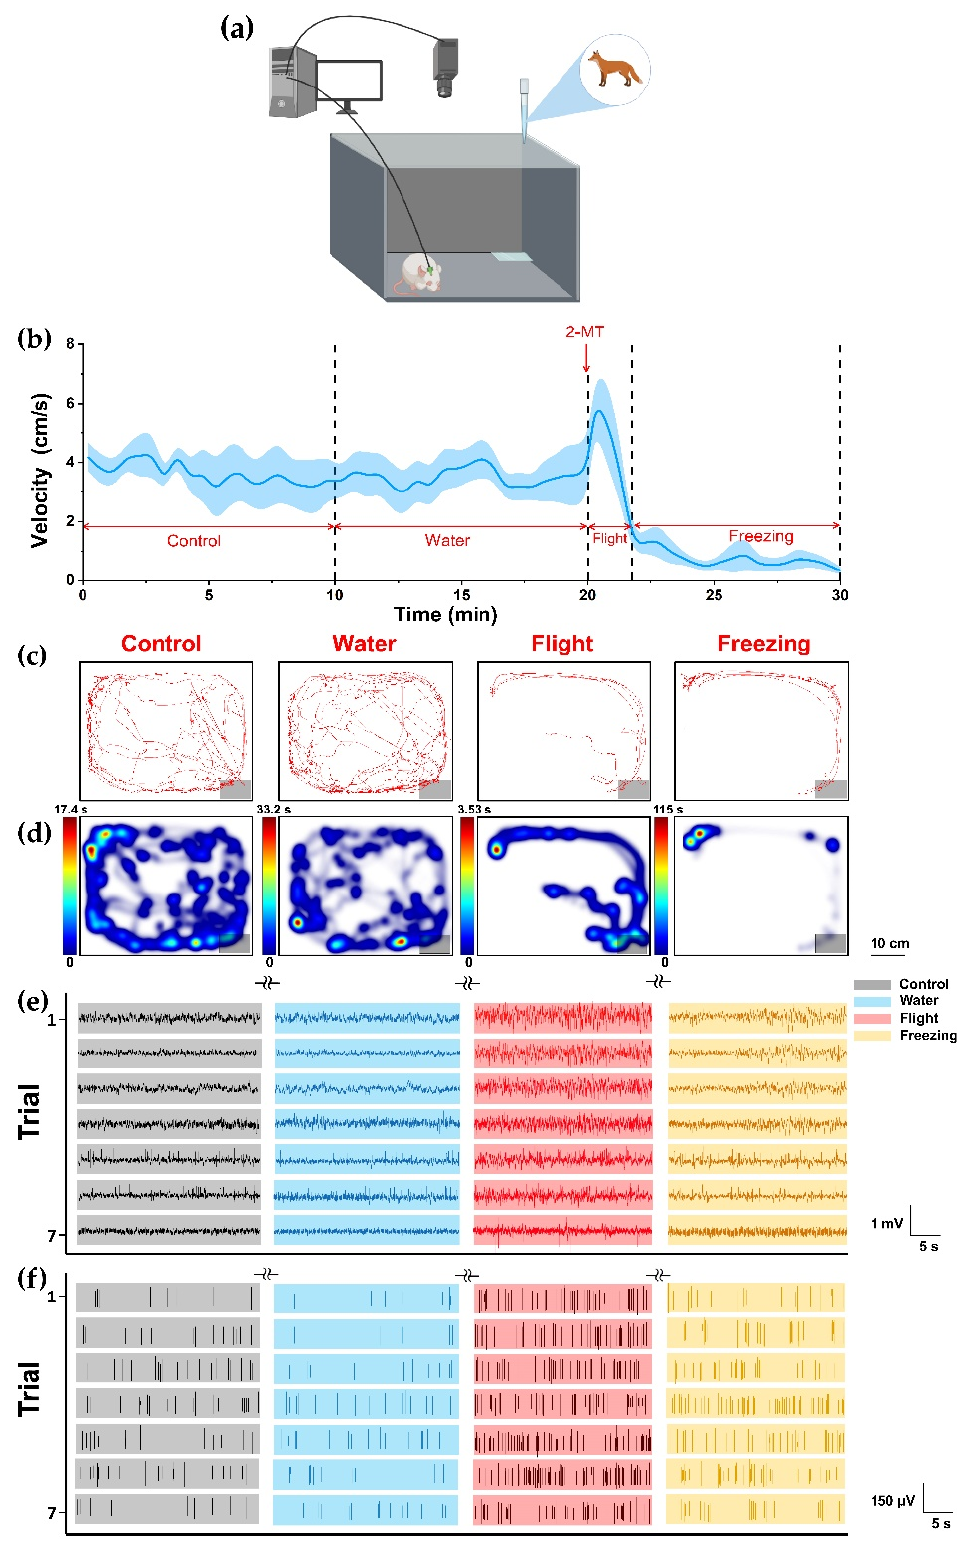
Figure 2. Behavior and electrophysiological activity records of predator odor induced defensive behavior in rats. ( a ) Schematic diagram of innate fear induced by 2-MT in rats; ( b ) average instantaneous velocity of rats in the experiment. The data were the average speed in every 20 s; ( c ) locomotion tracks and ( d ) heatmap of a representative rat in the four states, the gray area indicated the location of the filter paper; ( e ) spike and ( f ) LFP of seven typical channels.